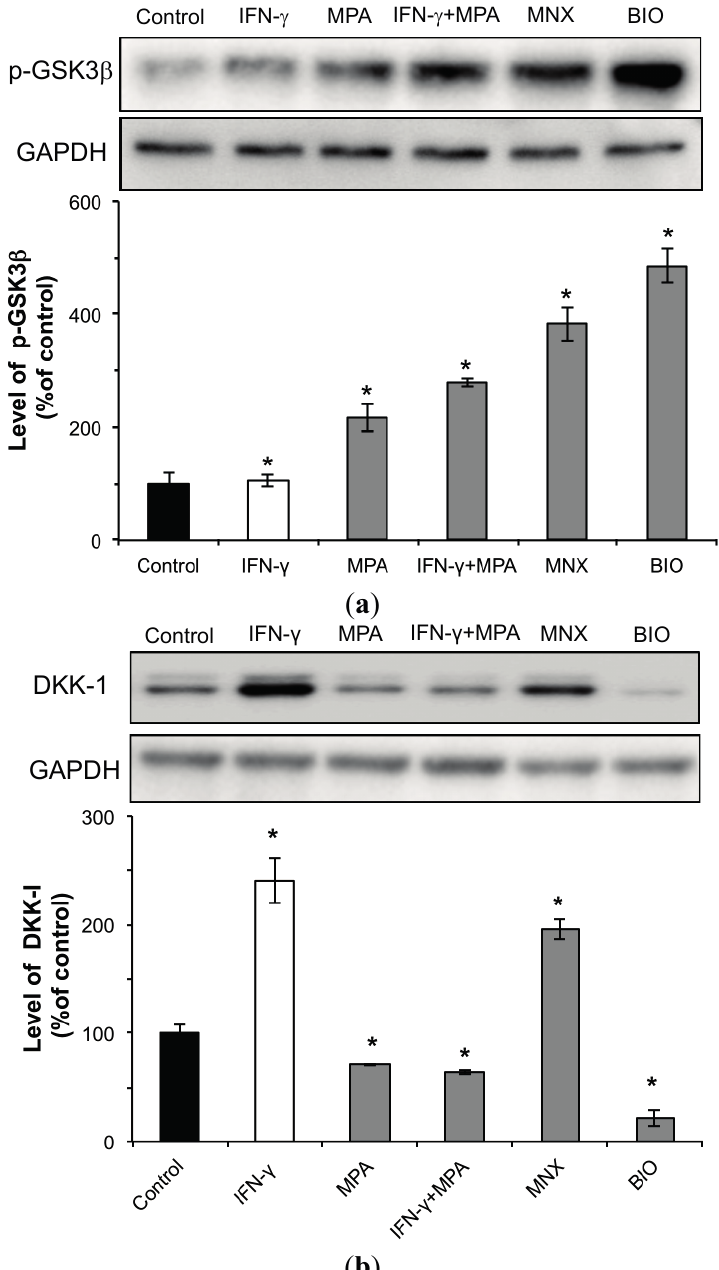
Figure 3. Phosphorylation of GSK3 β and expression of DKK-1 in hDPCs following treatment with MPA and/or IFN- γ . hDPCs were treated with 100 ng/mL of IFN- γ , 100 nM of MPA, or with both IFN- γ and MPA for 48 h. The levels of phospho-GSK3 β ( a ) and DKK-1 ( b ) were examined by Western blot using anti-phospho-GSK3 β or anti-DKK-1 antibodies, respectively. Each relative protein level of phospho-GSK3 β and DKK-1 is also shown as mean ± SD from three independent experiments. Statistically significant differences were determined by ANOVA ( * p < 0.05). MNX and BIO served as positive controls for phosphorylation of GSK3 β and expression of